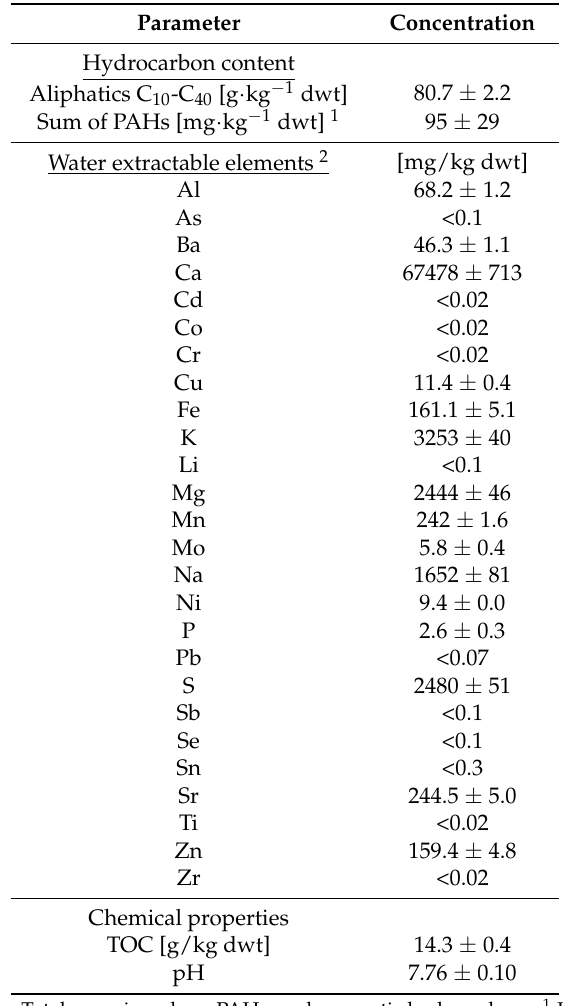
Table 1. Soil characteristics (average ± standard deviation, n =